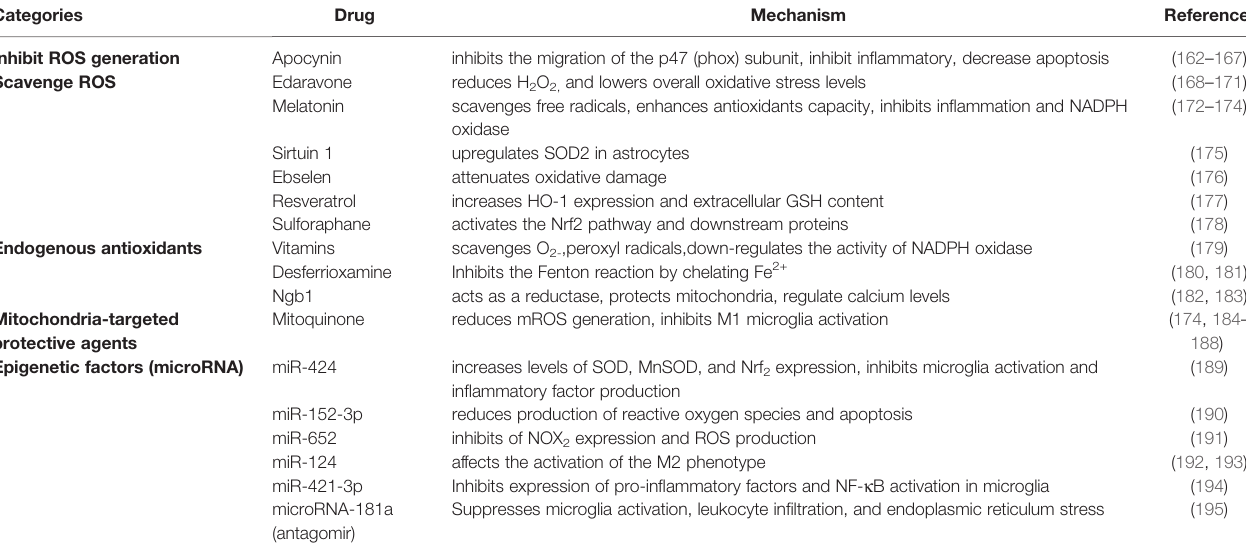
TABLE 1 | Approaches to post-stroke oxidative